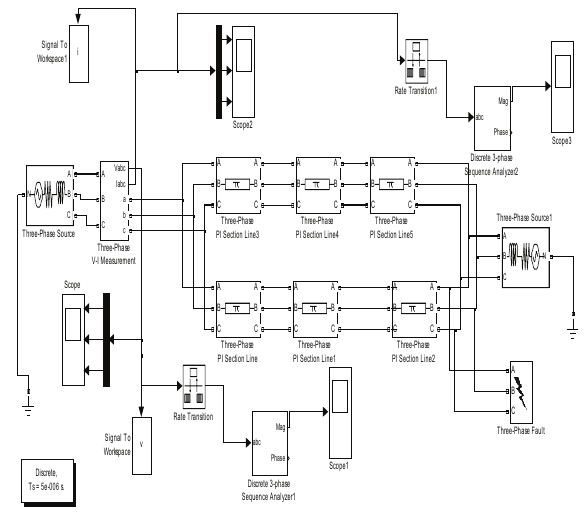
Fig.2.Simulation model of EHV double circuit transmission line